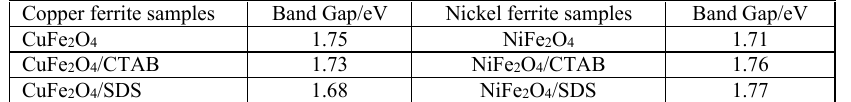
Table 2. The calculated band gap energies of samples.